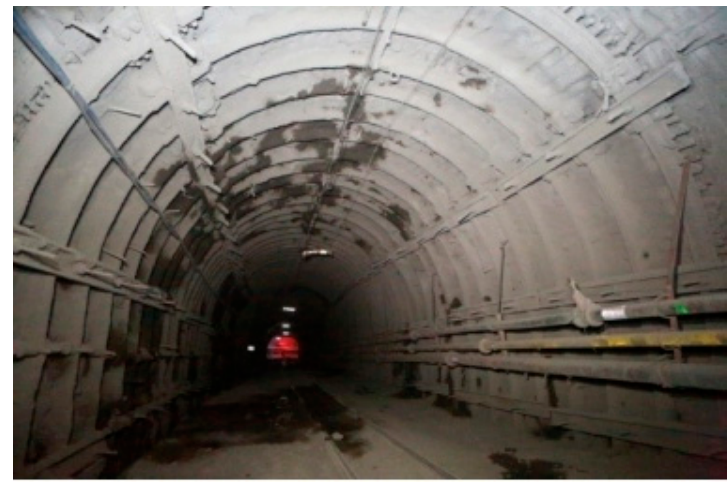
Figure 16. Tested support scheme.